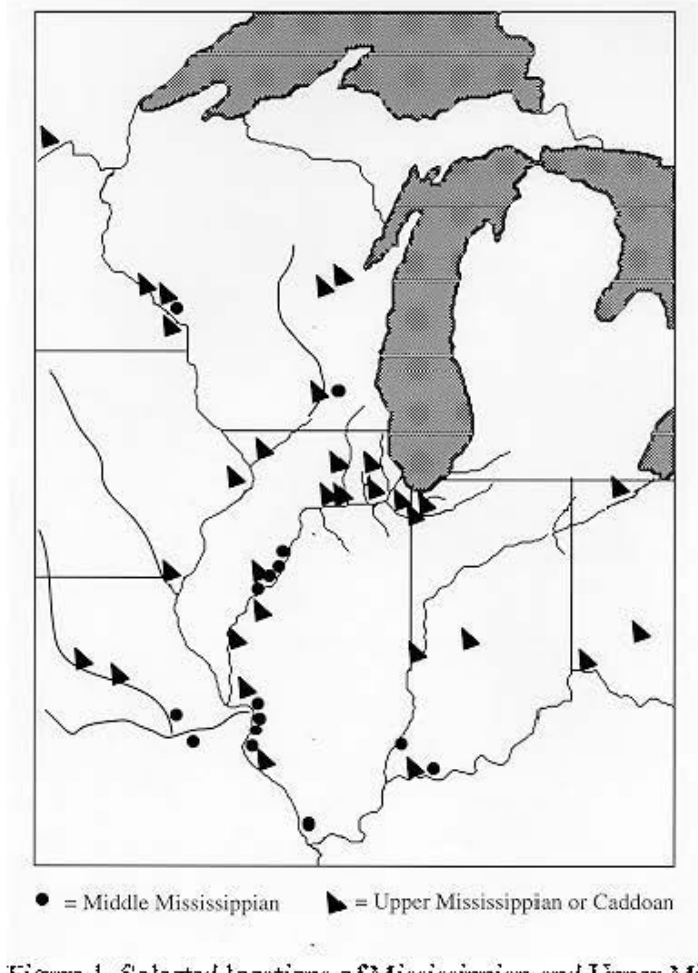
figure I. Selected locations of Mississippian and lJppcr Mississippian sites in the Upper